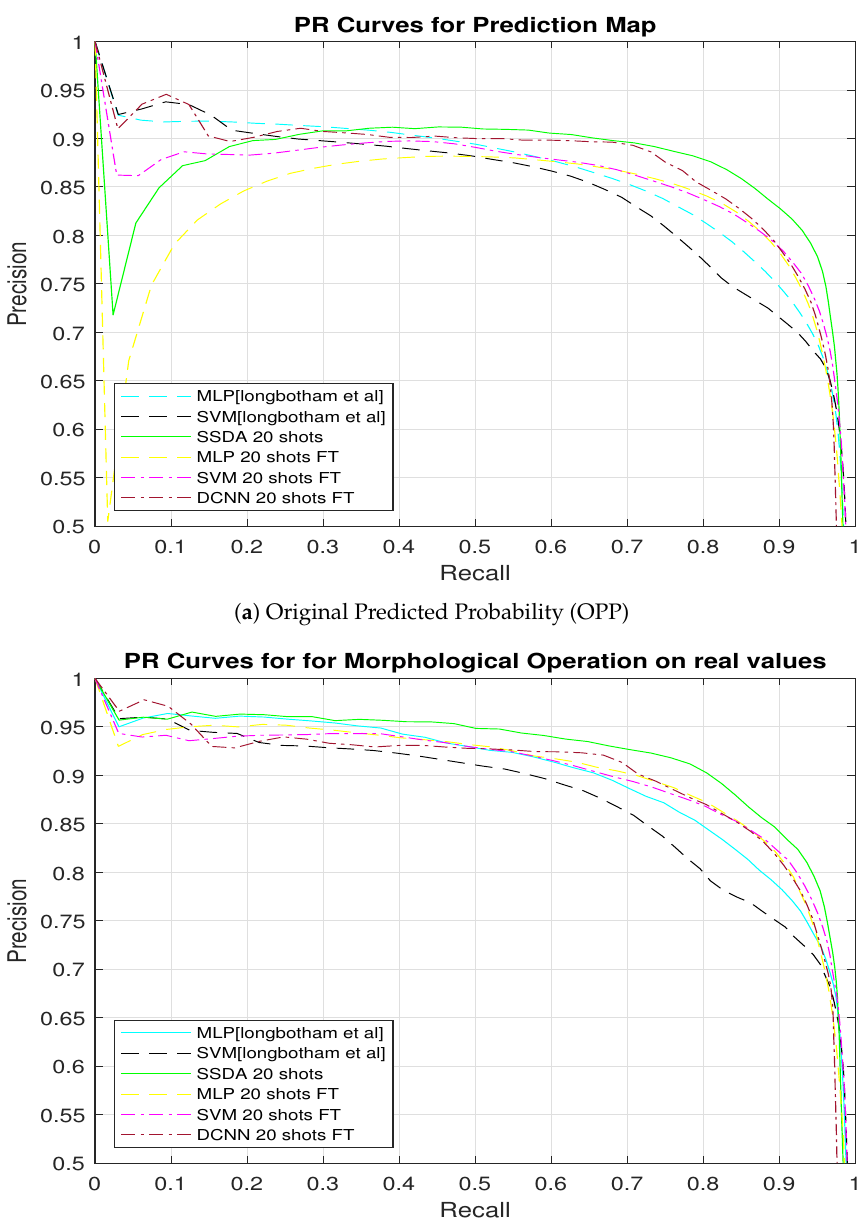
Figure 8. PR curves by different approaches on: ( a ) OPP map and ( b ) MO-DS map. Results after Morphological Operation with Disk Structure on OPP (MO-DS) To remove the false positive points from the OPP maps, we applied morphological operation on the maps with a structuring element size of 5. The classification maps for different models are shown in Figure 9 and performance metrics shown as ‘MO-DS’ are listed in Table 1. Similarly, we display the probability maps using ‘jet’ colormaps where blue represents the probability ‘0’ whereas red represents the probability of ‘1’. The PR curves for the last six flood-detection scenarios in Table 1 are shown in Figure